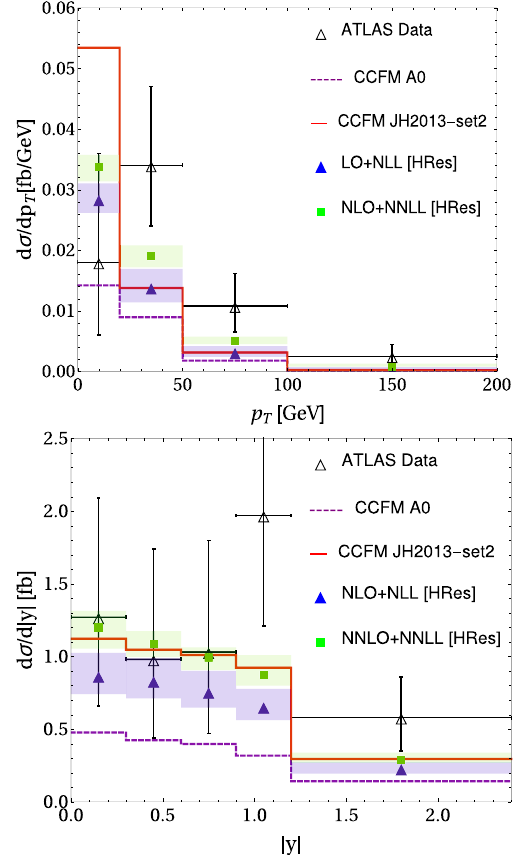
Fig. 2 Differential cross section of the Higgs boson production as a function of transverse momentum ( p T ) and rapidity ( y ) of the Higgs √ S = 8 TeV. Solid (red) line and boson in four-lepton decay channel at dashed(purple)lineisaresultobtainedusing k T -factorizationapproach with CCFM JH2013-set2 and CCFM A0 unintegrated gluon densities respectively. Filled triangle and filled square points corresponds to esti- mates obtained using HRes tool [28,76] up to NNLO + NNLL accuracy and shaded region corresponds to scale uncertainty in renormalization and factorization scale. Experimental data points are from ATLAS [62]. The error bars on the data points shows total (statistical ⊕ systematic)